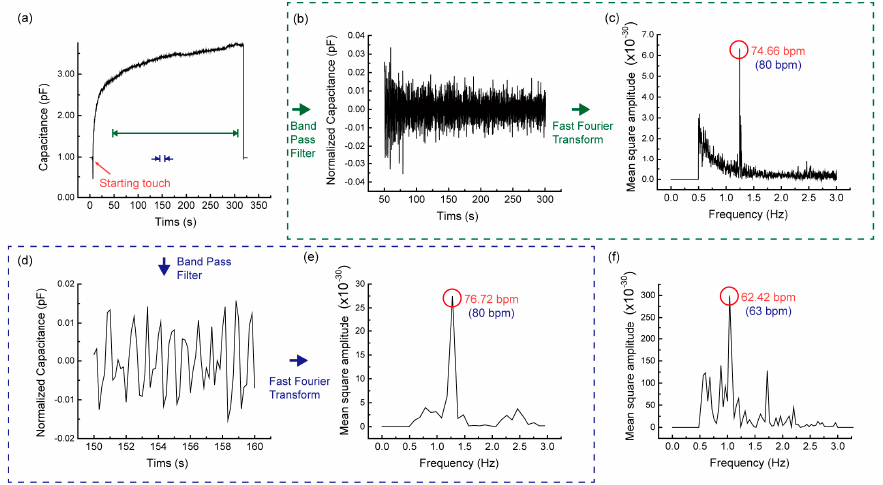
Figure 4. ( a ) The time trend of capacitance measured for heart-rate sensing without cover layer. The green dotted-line encloses the signal processing results for the oscillatory part of measured capacitance within the time interval of ~250 sec and the blue dotted-line encloses the corresponding results for the time interval of ~10 sec. ( b ), ( d ) show the normalized capacitance after going through band pass filtering (0.5–3.0 Hz) and ( c ), ( e ) show the frequency spectrum obtained with the subsequent fast Fourier transformation (FFT), ( f ) is the frequency spectrum of the capacitance signal measured for a different person which results from the same signal processing procedures.